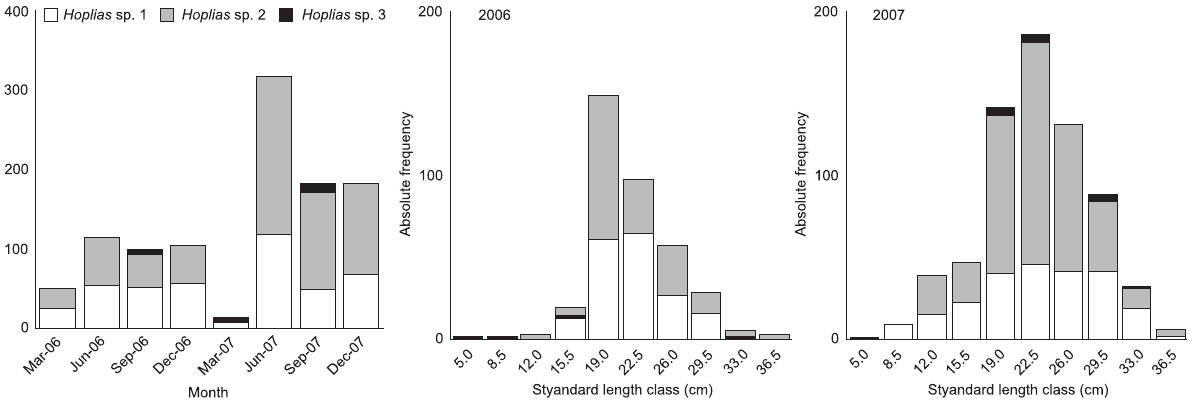
Figure 3. Absolute frequency of Hoplias sp. 1, Hoplias sp. 2 and Hoplias sp. 3 by month and by standard length class, in 2006 and 2007, in the Upper Paraná River floodplain Table I. Sex ratio of the species of Hoplias by year. (N) Number of specimens, (%) frequency percentage, (*) significant at the level of 5%, ( (cid:2) ) impossible to calculate G. 2006 2007 Species Female Hoplias sp. 1 Hoplias sp. 2 Hoplias sp.